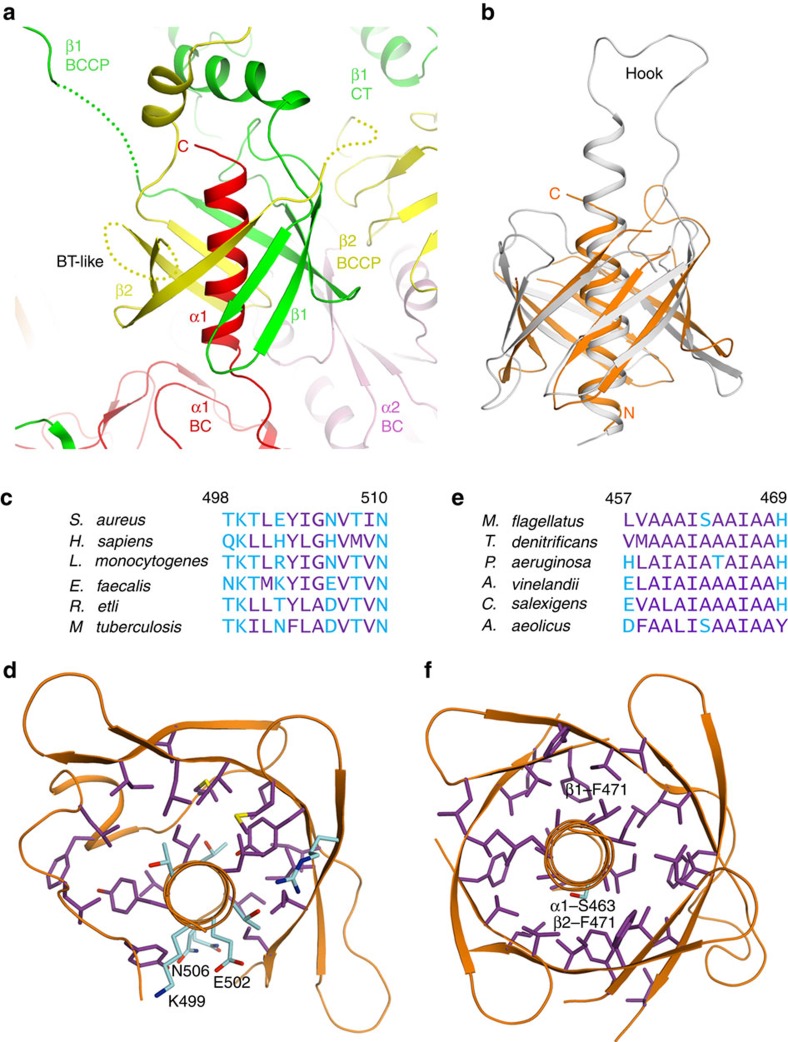
A BT-like domain in the structure of two-subunit PC.(a) Schematic drawing of the BT-like domain in MfPC. The helix comes from the α subunit (red), and the two four-stranded β-sheets come from two separate β subunits (green and yellow). Each subunit is given a different colour to highlight the origins of the protein segments in the BT-like domain. (b) Overlay of the structures of the BT-like domain of MfPC (orange) and the BT domain of PCC (grey)20. (c) Sequence alignment of the residues in the α helix of the PT domain in single-chain PCs. Hydrophobic residues are coloured purple, and hydrophilic ones in cyan. (d) The α helix of the PT domain in SaPC is amphipathic, with half of its surface having hydrophilic residues and exposed to the solvent. Hydrophobic side chains are coloured in purple, and hydrophilic ones in cyan. (e) Sequence alignment of the residues in the α helix of the BT-like domain in two-subunit PCs, at the C-terminal end of the α subunit. (f) The α helix of the BT-like domain in MfPC is hydrophobic, completely surrounded by the β-barrel and having mostly small side chains.